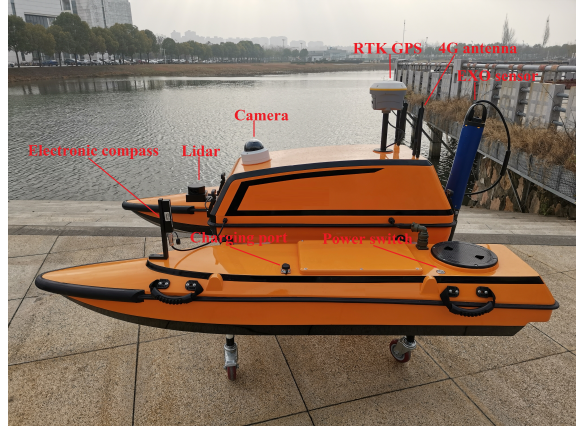
Figure 20. USV and components.